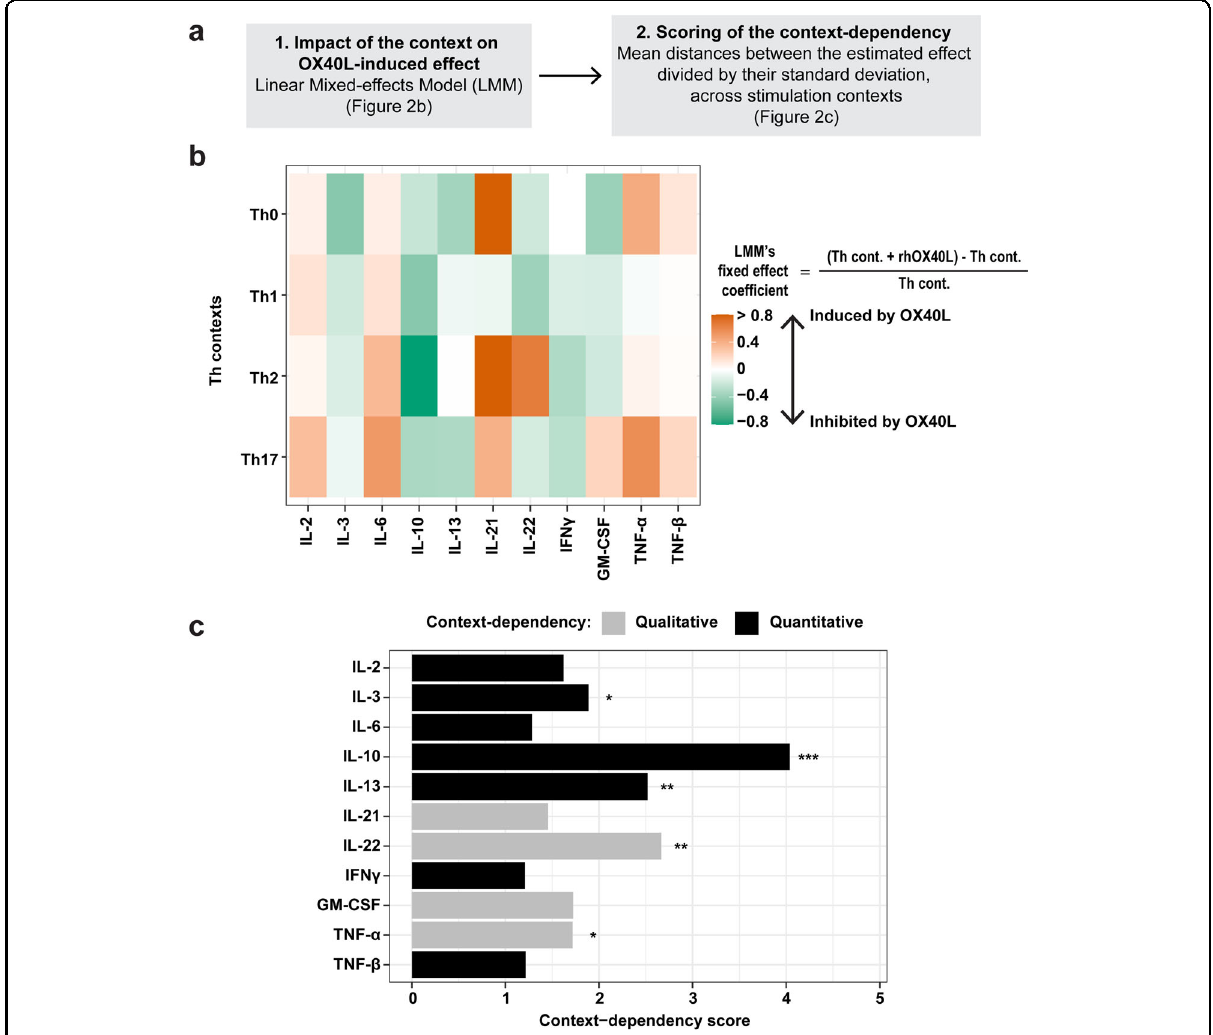
Fig. 2 OX40L context-dependency across molecular contexts is the strongest on IL-10. a Simpli fi ed mathematical modeling strategy used to quantify and score the context-dependent impact of OX40L on output cytokines. In the following analyses, IL-4, IL-5, IL-9, IL-17A, IL-17F and IL-31 were excluded to avoid bias because they were produced in only one or two contexts. b Heatmap representing the estimated OX40L-induced relative difference for the 11 output Th-cytokines measured in each Th context, calculated using Linear Mixed-effects Models (LMM) on 13 independent donors. The estimated coef fi cients for the fi xed effects from the models are represented. For a given cytokine, in a given Th context, the LMM ’ s fi xed effect coef fi cient corresponds to the mean over donors of the concentration in the presence minus absence of rhOX40L, divided by the concentration in the absence of rhOX40L. c Scoring of the context-dependency across the four Th-polarizing contexts. Black bars represent a quantitative OX40L context-dependency, meaning variation of a considered output cytokine in one direction (increase or decrease) in all the Th contexts. Grey bars indicate a qualitative OX40L context-dependency, meaning variation of an output cytokine in the opposite direction in at least one Th context. The scores were computed from 13 independent donors. Likelihood ratio tests, between the LMM with and without the context variable as a fi xed effect, were performed to evaluate the signi fi cance of the context-dependency. * P ≤ 0.05; ** P ≤ 0.01; *** P ≤